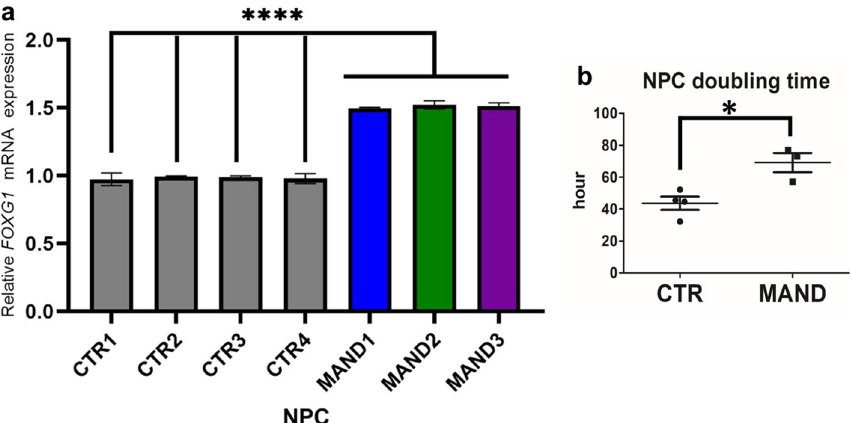
Figure 5. MAND-associated 2q23.1 deletion including MBD5 results in de-repression of FOXG1. ( a ) Altered expression of FOXG1 in MAND NPCs. Quantitative real-time PCR was performed on MAND NPC and control NPC lines. Levels of FOXG1 mRNA were calculated relative to that of the housekeeping gene GAPDH . All expression values were calculated relative to control levels set at 1.0. Error bars represent the SEM. **** p < 0.0001, n = 3 independent biological replicates performed in triplicate. ( b ) Comparison of cell doubling time between MAND NPC and control NPC lines. Error bars represent the SEM. * p = 0.0152, GraphPad Prism 8.4.2